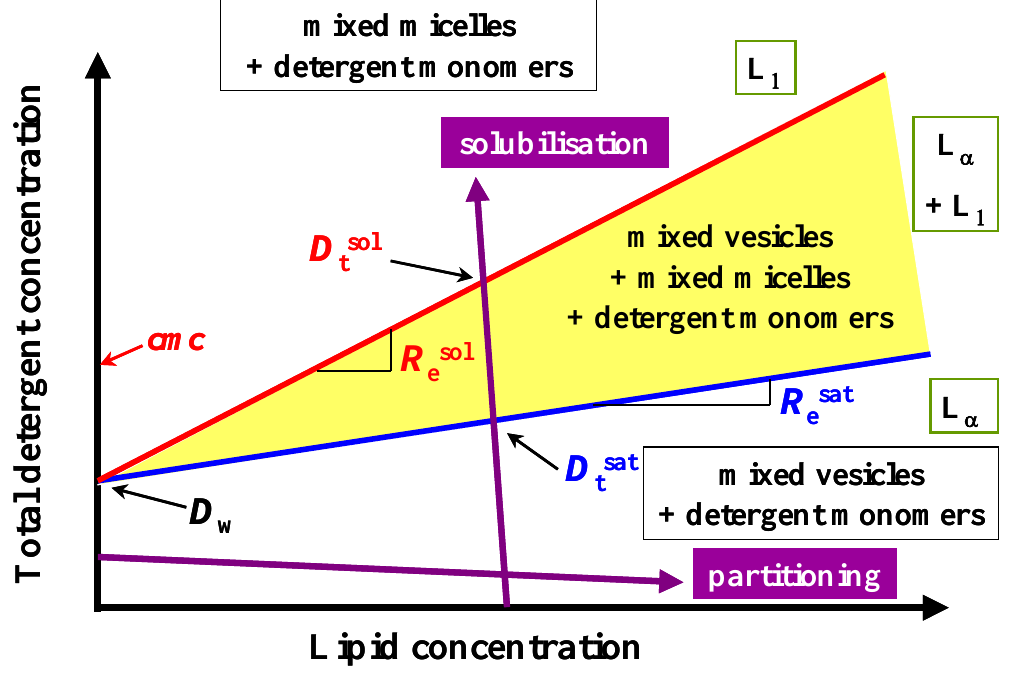
Figure 2. Schematic phase diagram of lipid/detergent mixtures, a so-called total detergent ) versus lipid concentration ( L ) phase diagram, representing the liposome to concentration ( D t micelle transition. The blue and red lines indicate the phase boundaries D tsat and D tsol for saturation (sat) respectively solubilisation (sol) process. The detergent to lipid ratio is given by R esat and R esol , and the hypothetical detergent concentration in the presence of lipid D wsat : liquid crystalline phase, L micellar and D wsol for the saturation and solubilisation. L 1 α